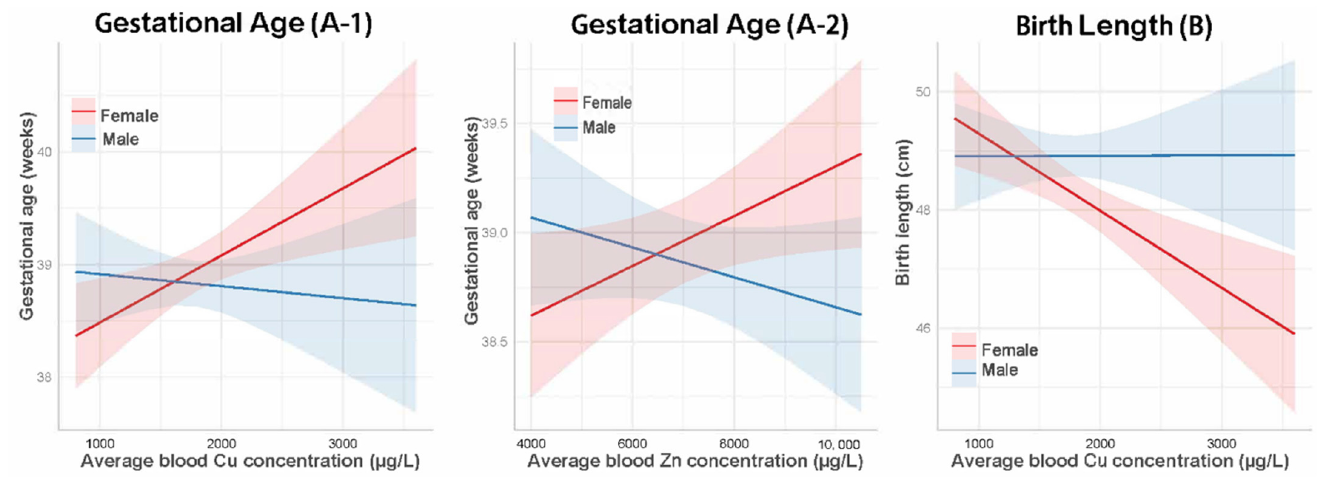
Figure 3. Interaction effects of infant sex on the association between average maternal Cu concen- tration and gestational age and birth length; and the relationship between average maternal Zn level and gestational age. Models ( A-1 , A-2 ) were adjusted for maternal age, parity, pre-pregnancy BMI, smoking, education, birth weight, and birth length. Model ( B ) was adjusted for maternal age, parity, pre-pregnancy BMI, smoking, education, and gestational age. Abbreviations: Cu, copper; Zn, zinc.